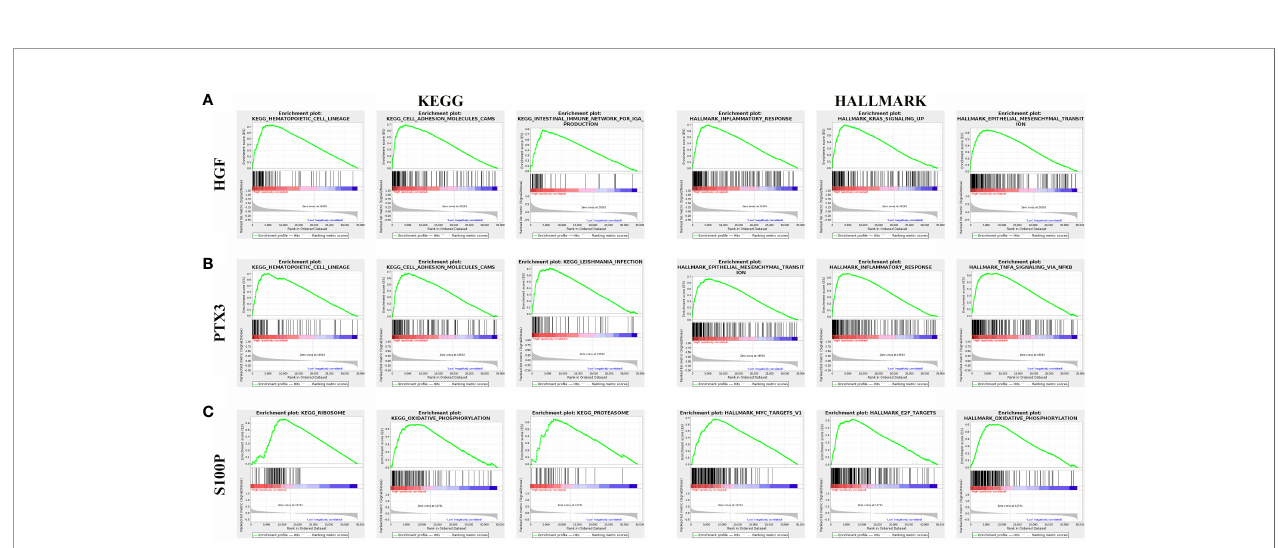
FIGURE 10 | Gene set enrichment analysis of three genes associated with signaling pathways in KEGG and hallmark datasets. (A) Results of GSEA of HGF ranked in the top three for its correlation with signaling pathways in KEGG and HALLMARK database. (B) Results of GSEA of PTX3 ranked in the top three for its correlation with signaling pathways in KEGG and HALLMARK database. (C) Results of GSEA of S100P ranked in the top three for its correlation with signaling pathways in KEGG and HALLMARK